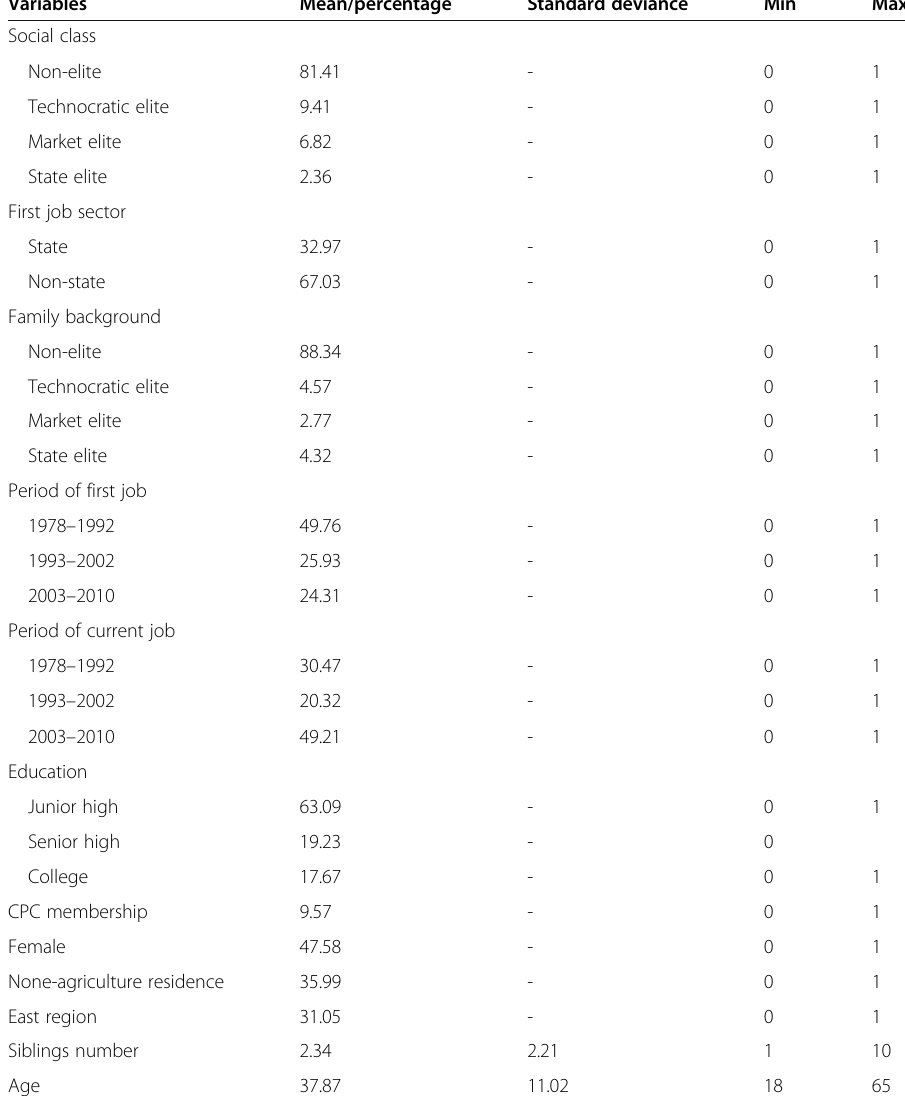
Table 1 Weighted descriptive statistics of variables ( N =